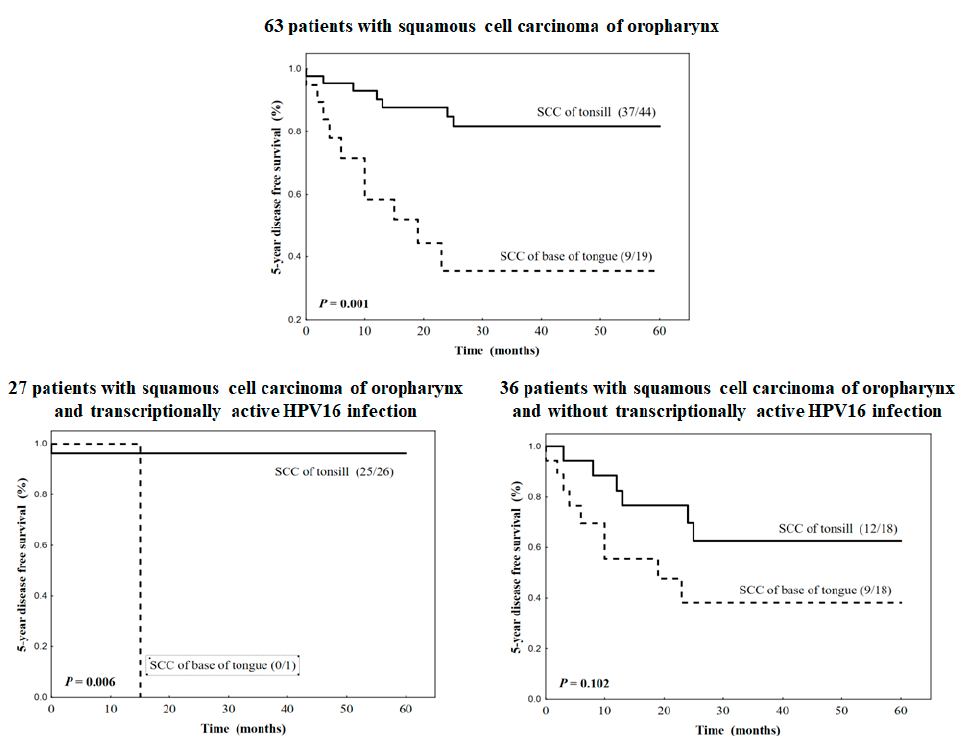
Figure 1. Kaplan–Meier curves concerning disease-free survival stratified by localization of tumors in the group of 63 patients with squamous cell carcinomas of the oropharynx and into two subgroups identified by the prevalence of transitionally HPV16 infection.